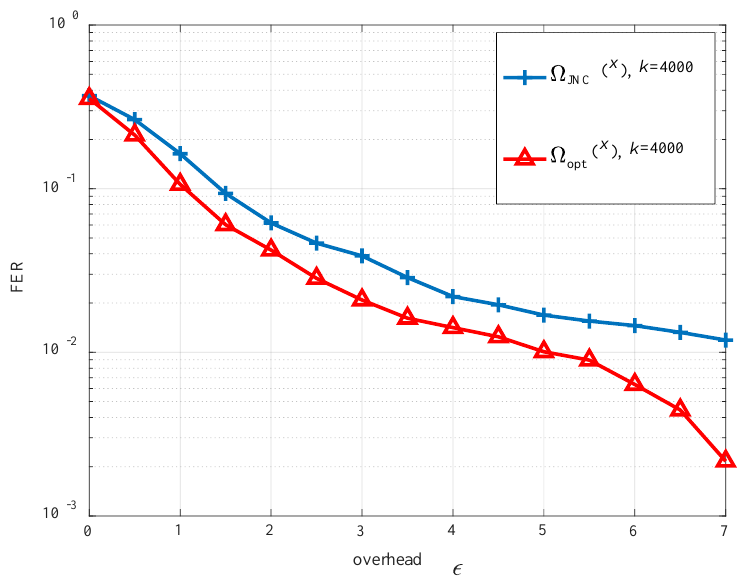
Figure 7. FER performance of SLT-coded MF-TWRN using di ff erent degree distributions with k = 4000.